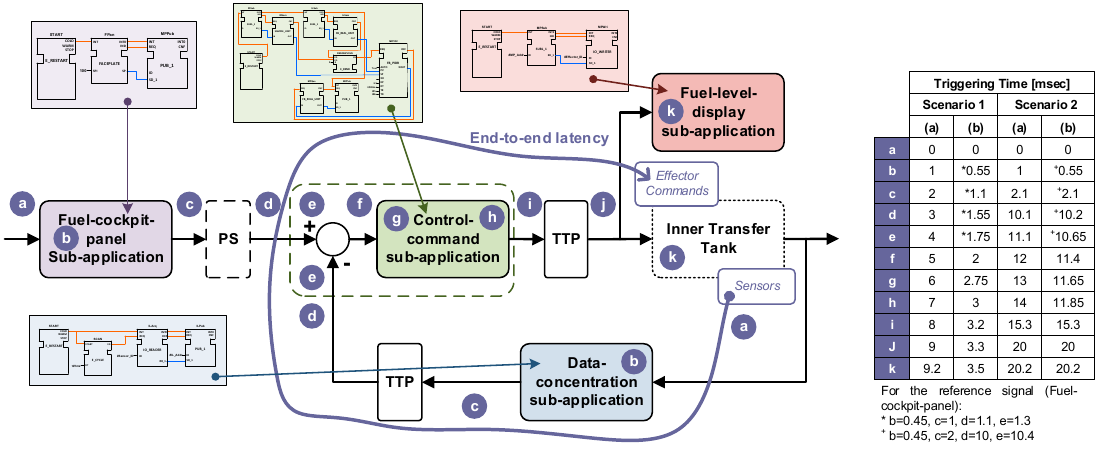
Figure 19. End-to-end latency in the control loop of the Distributed Avionics Application (DAA).